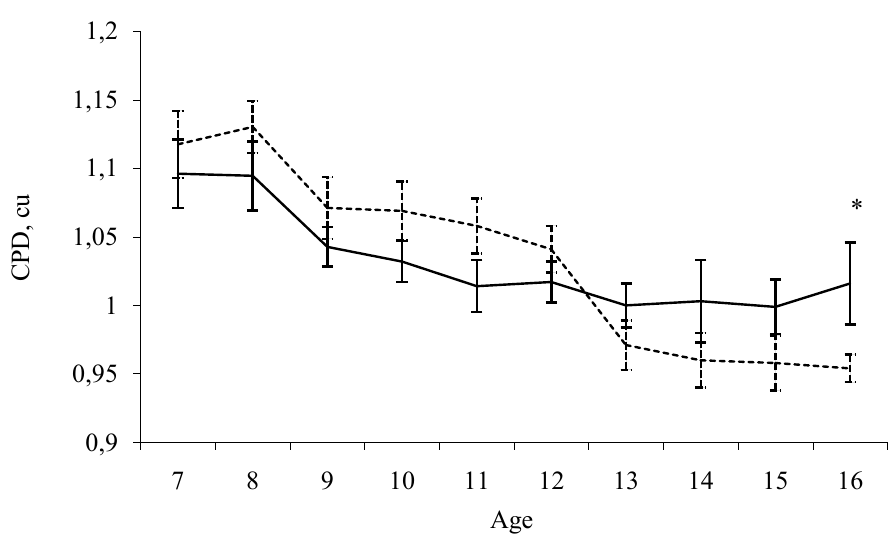
Fig.1. Age Dynamics of Physical Development Coefficient at Boys and Girls aged 7-16; * - probability of differences (р<0.05) of average indexes at girls and